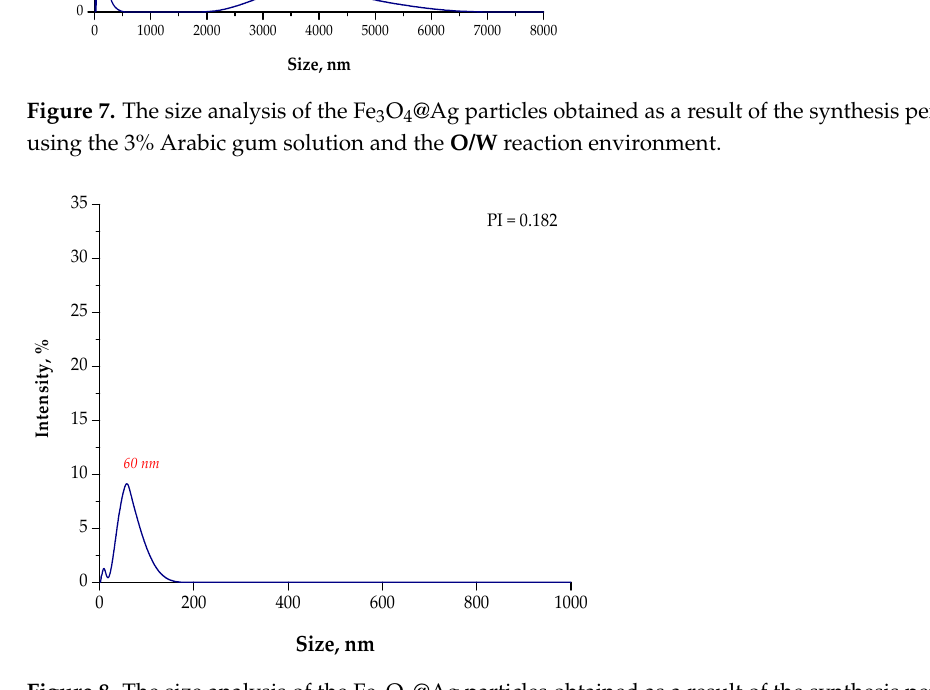
Figure 8. The size analysis of the Fe 3 O 4 @Ag particles obtained as a result of the synthesis performed using the 3% Arabic gum solution and the oil/water ( O/W ) reaction environment after 15 min of sonication.